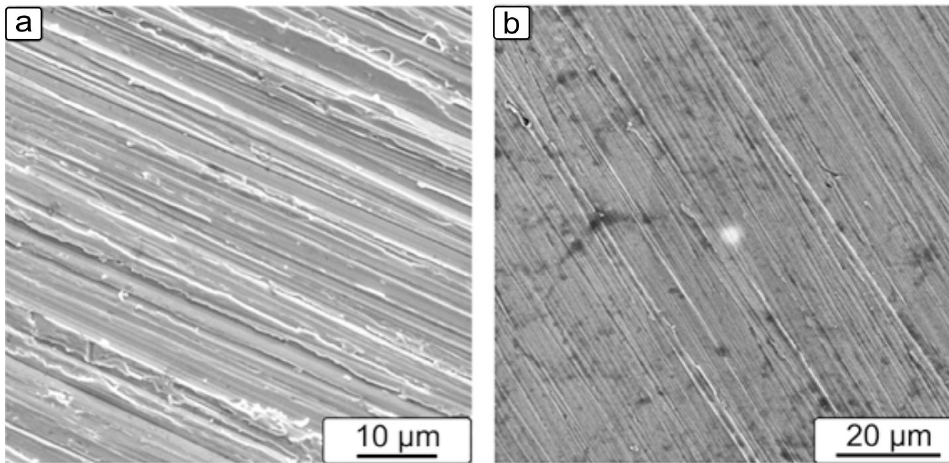
Figure 9. SEM images of SS 316L ( a ) and SS 304L ( b ) prior corrosion testing.